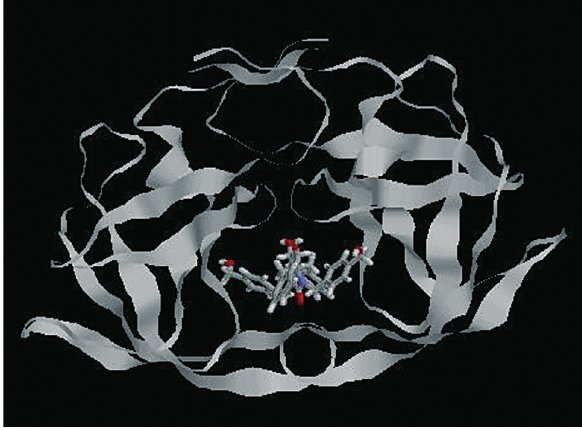
Figure 2 - The DMP323 ligand in the HIV-1 protease active